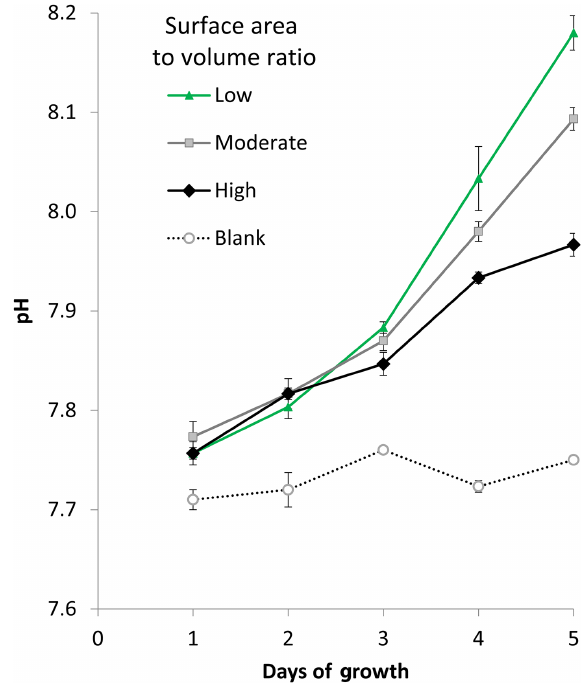
Figure 2. Flasks with high surface area to volume ratios show more evidence of atmospheric equilibration compared to low surface area to volume flasks when biomass and air–water CO 2 gradients are high after several days of growth. Treatments represent triplicate batch cultures of Emiliania Huxleyi . Surface area to volume ratios tested are 90 (low), 116 (moderate), and 162 (high)cm 2 L − 1 , corre- sponding to volumes of 900, 700, and 500mL in a square 1L flask ( n = 3). Blanks, which do not contain algal cells, retain relatively constant pH (total scale). Values are means; error bars are standard